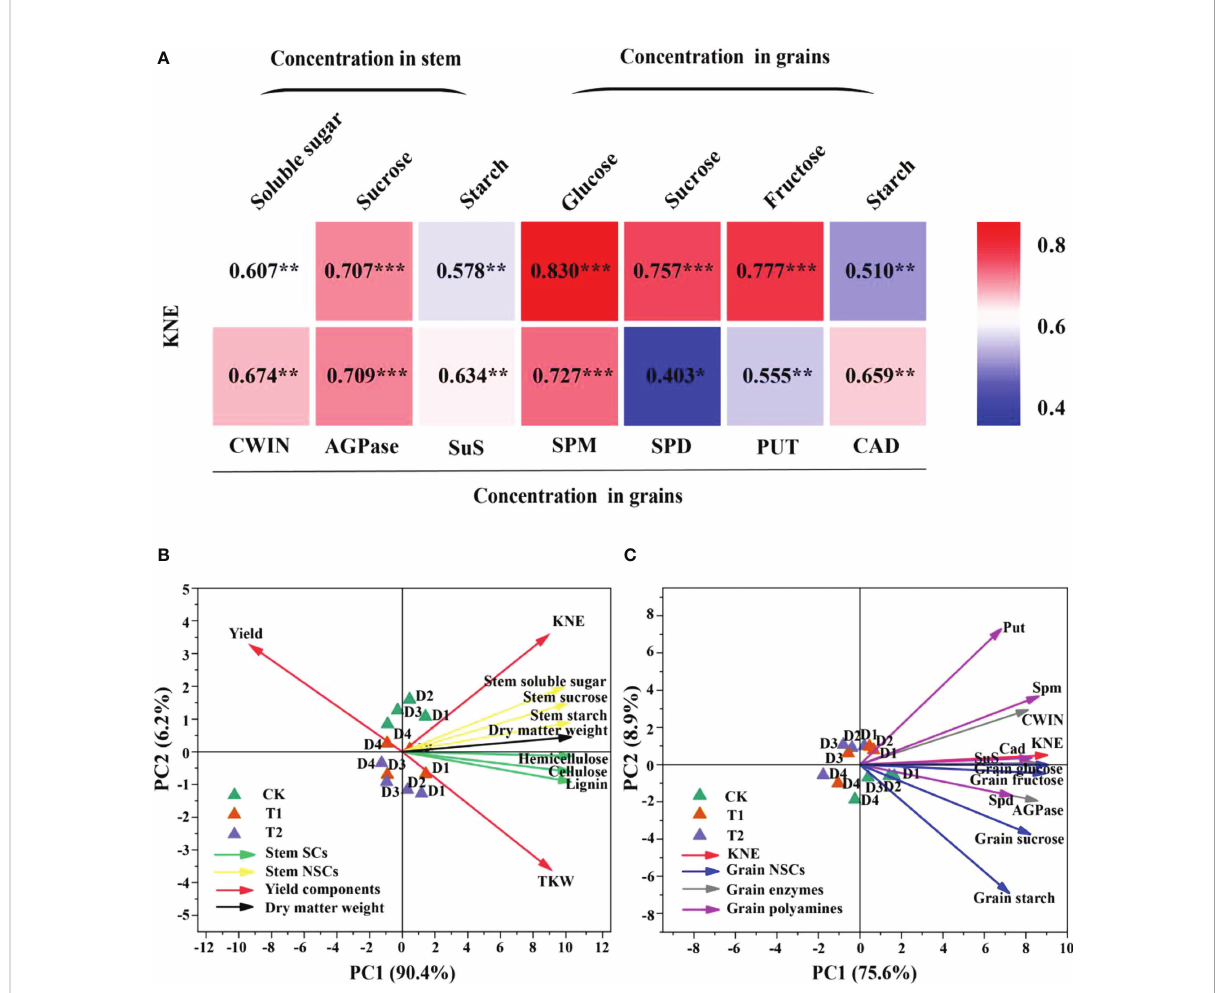
FIGURE 6 Relationships between soluble sugar, sucrose, and starch in stem and glucose, sucrose, fructose, starch, cell wall acid invertase (CWIN), adenosine diphosphate pyrophosphorylase (AGPase), sucrose synthase decomposition direction (SuS), spermidine (Spm), spermidine (Spd), putrescine (Put), and cadaverine (Cad) in grains with KNE in 2021 ( n = 12 ) (A) . The numbers in the fi gure represent R 2 , the coef fi cient of determination. R 2 > 0.4 and P < 0.05 indicate a signi fi cant relationship. *, **, and *** indicate signi fi cant differences at P< 0 . 05 , 0 . 01 , and 0 . 001 , respectively. KNE, kernel number per ear. Principal component analysis (PCA) of yield components, stem NSCs, stem SCs and stem dry matter weight (B) , and KNE, grain NSCs, grain enzymes and grain polyamines (C) in 2021. Vectors represent trait factor loading coordinates for PC1 and PC2. D1, D2, D3, and D4 indicated plant density at 4.5, 6.0, 7.5, and 9.0 plants m − 2 , respectively; CK, T1, and T2 indicated water control, 2 mL L − 1 EC (ethephon: cycocel = 3:1), 4 mL L − 1 EC, respectively. The data used for the regression analysis are the mean values under each